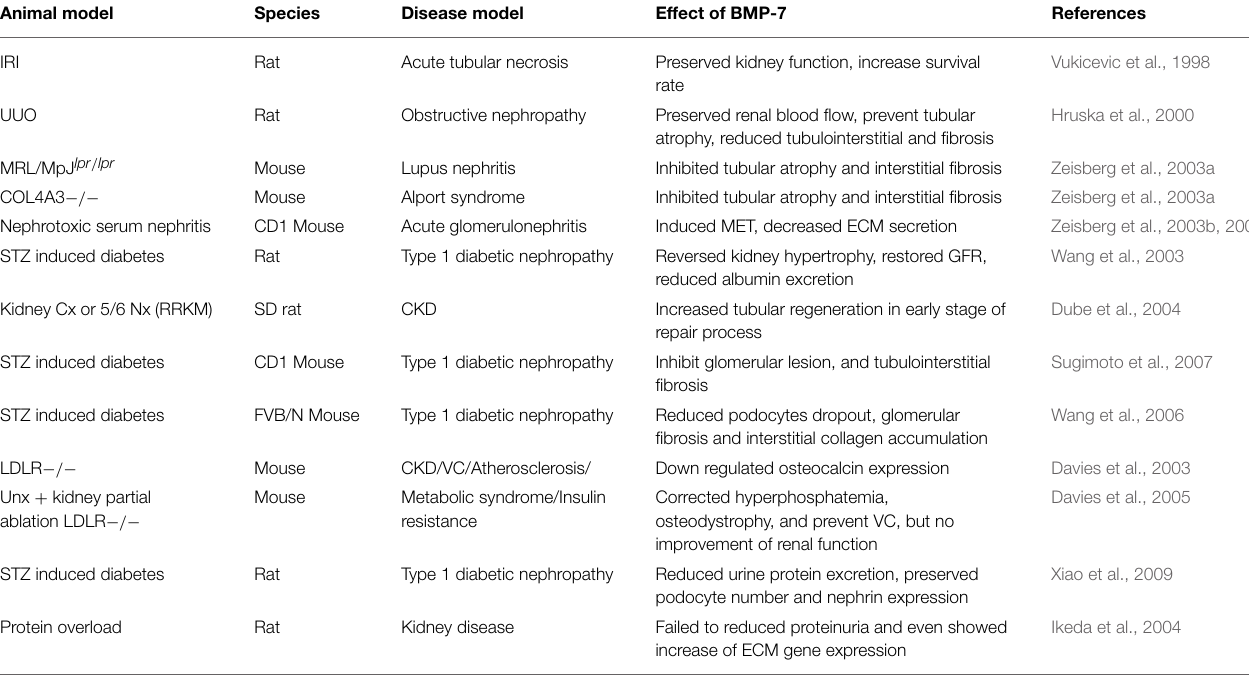
TABLE 1 | Published studies of BMP-7 as a therapeutic tool in animal models of kidney disease. Animal